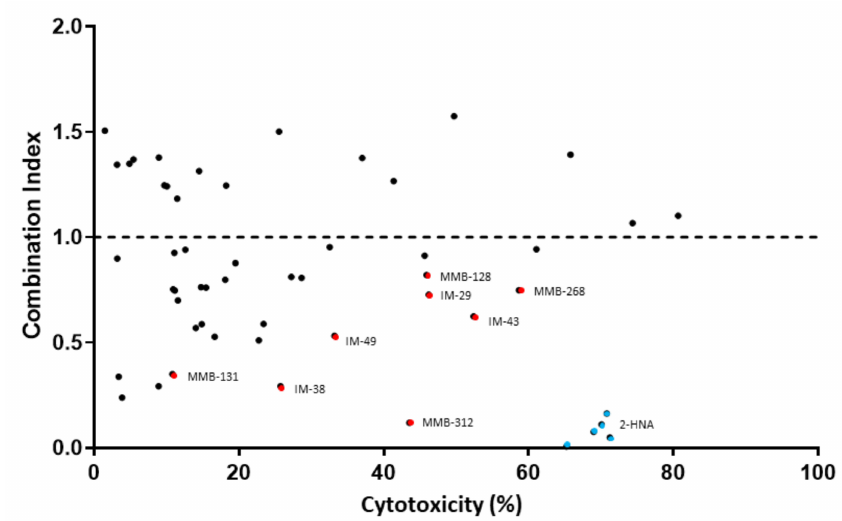
Figure 2. CI of compounds that were tested in combination with FK866 on OVCAR-5 cells. The cells were cultured in RPMI 1640 medium containing test compounds at a 100 µ M concentration with and without 100 nM FK866 and the cell viability was determined following 72 h treatments. The data are shown as CI vs. cytotoxicity exerted on cells. Blue dots represent the reference NAPRT inhibitor, 2-HNA. Red dots belong to the best performing test